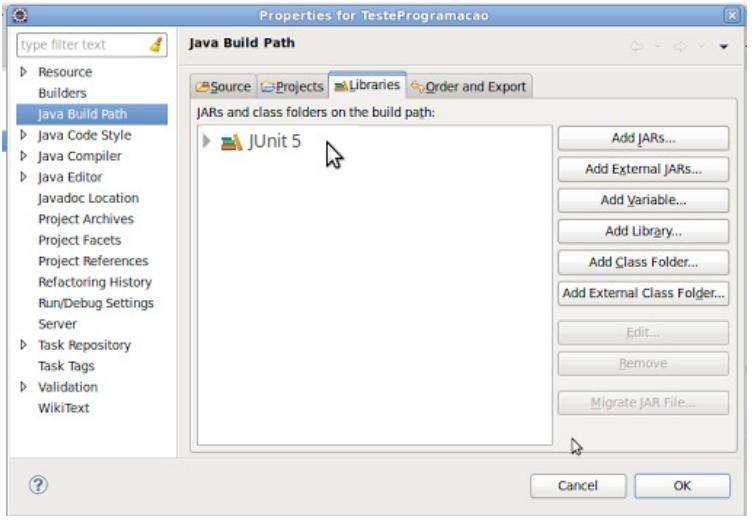
Figure 4. Adding JUnit to